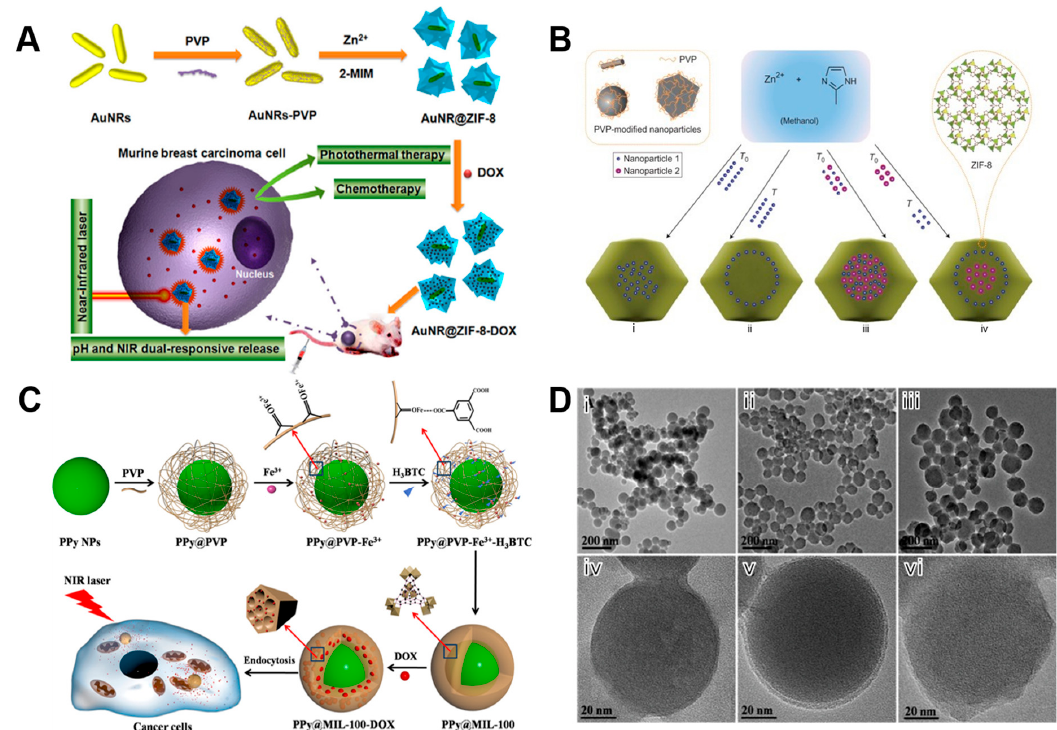
Figure 6. ( A ) Strategy for fabrication of AuNR@ZIF-8 core-shell nanostructures as a